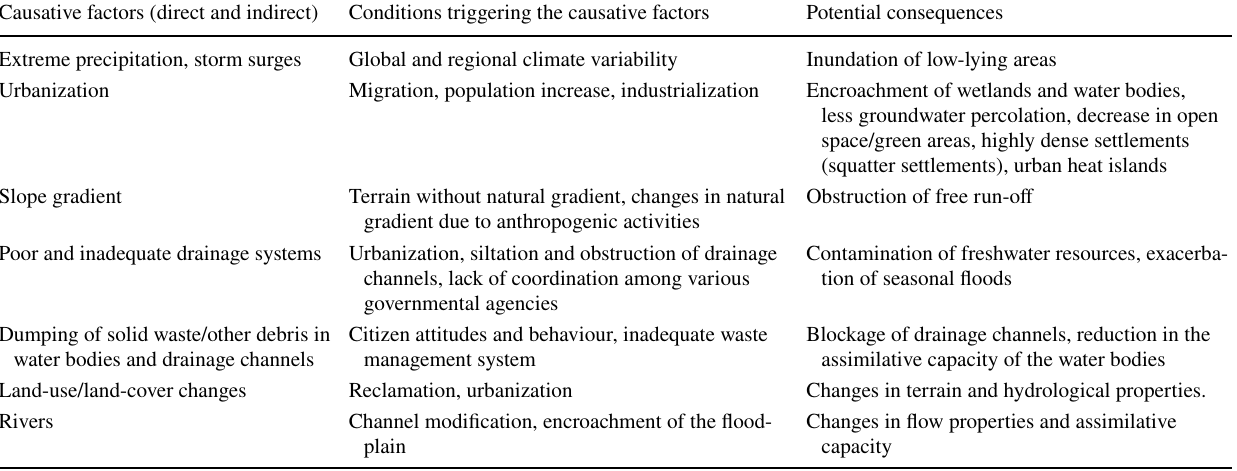
Table 1 Major causative factors leading to flood in Indian coastal cities and their consequences Causative factors (direct and